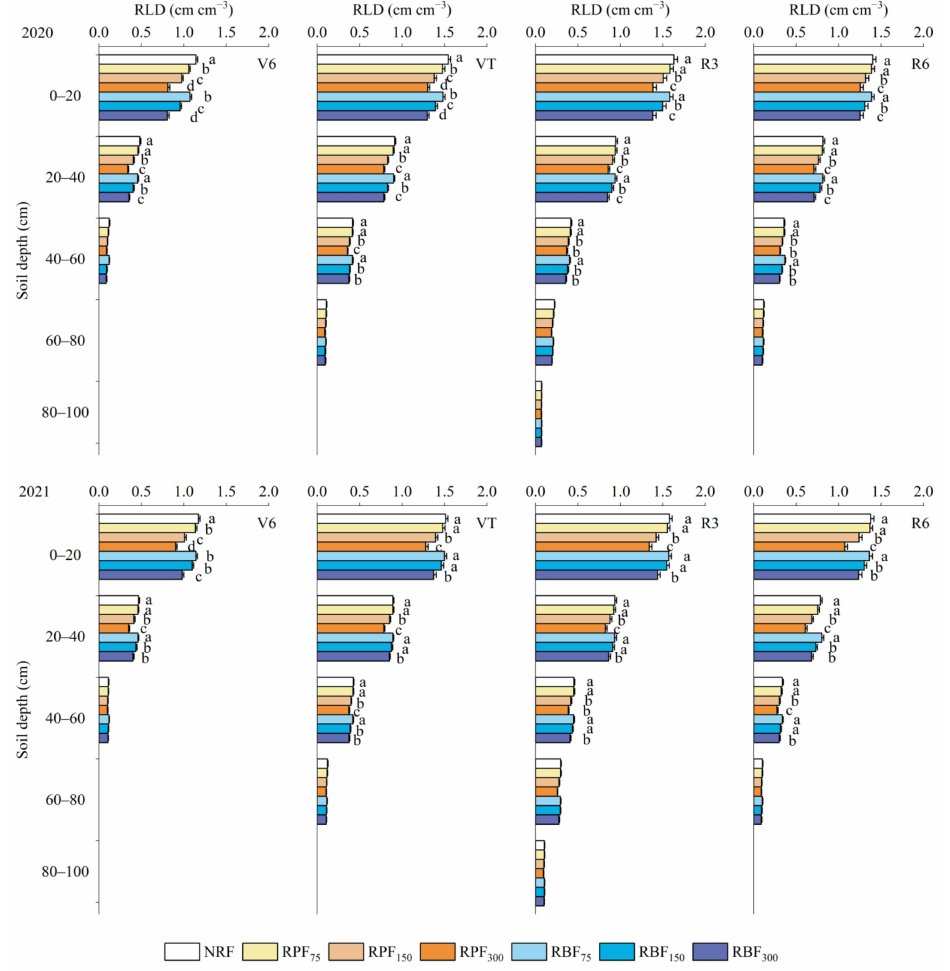
Figure 5. Root length density (RLD) in different soil layers in 2020 and 2021 spring maize growing seasons. Horizontal bars represent the standard error of the mean. Different lowercase letters indicate significant ( p < 0.05) differences based on the LSD